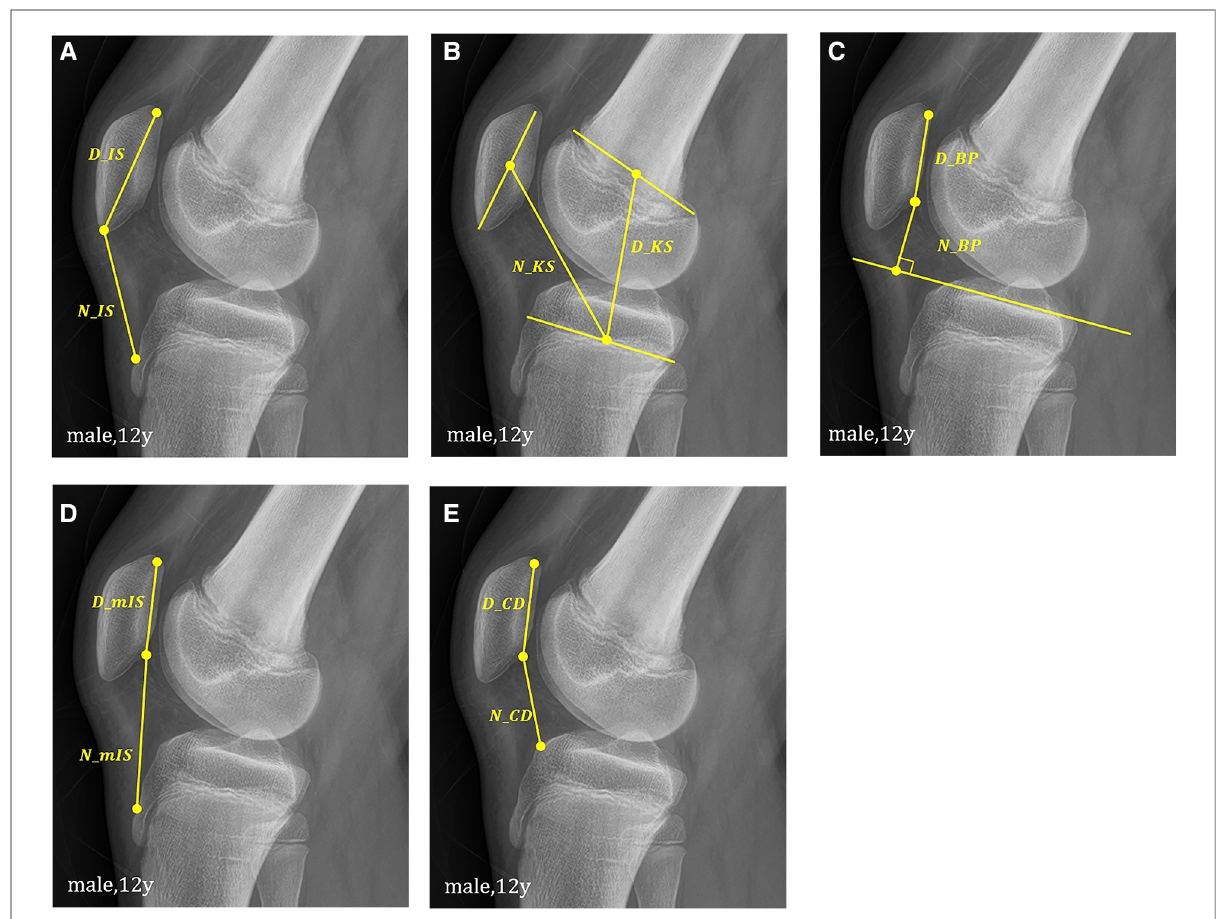
FIGURE 1 Schematic representation of ( A ) Insall-Salvati, ( B ) Koshino-Sugimoto, ( C ) Blackburne-Peel, ( D ) modi fi ed Insall-Salvati, ( E ) Caton-Deschamps